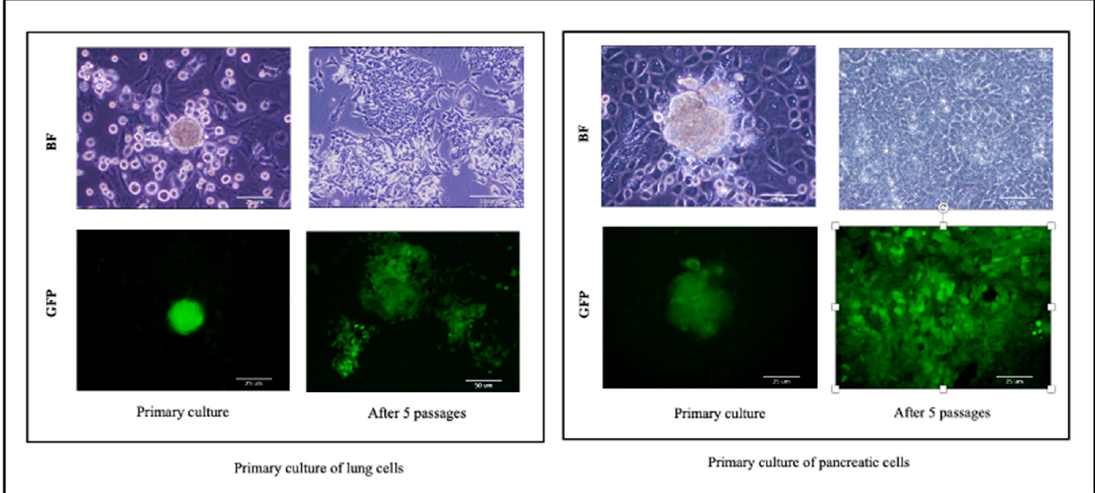
Figure 4. Primary cell cultures of metastatic tumors in pancreatic and lung. BF, bright field; GFP, detection of green fluorescence.